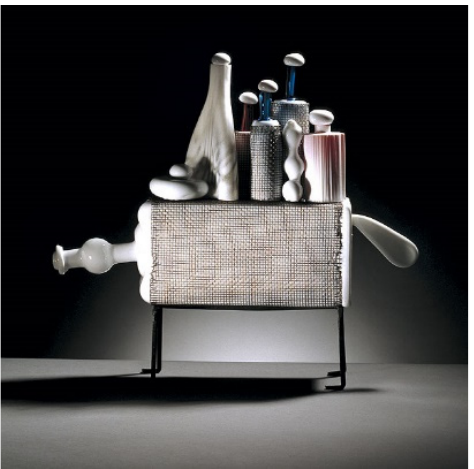
Figure 10. Markku Salo; Overload , 1996; fixed blown glass into wire mesh; courtesy of Markku Salo, used with permission.